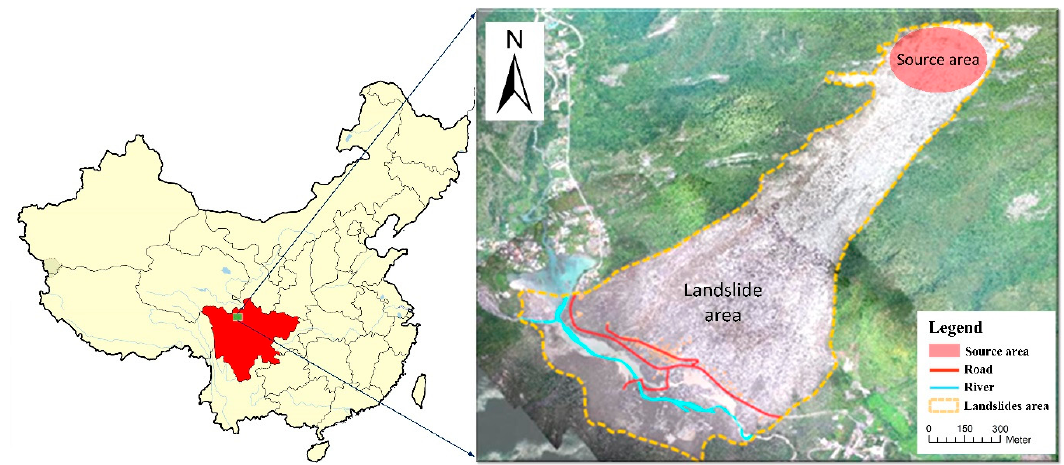
Figure 4. Case study area: a landslide in Diexi Town, Mao County.